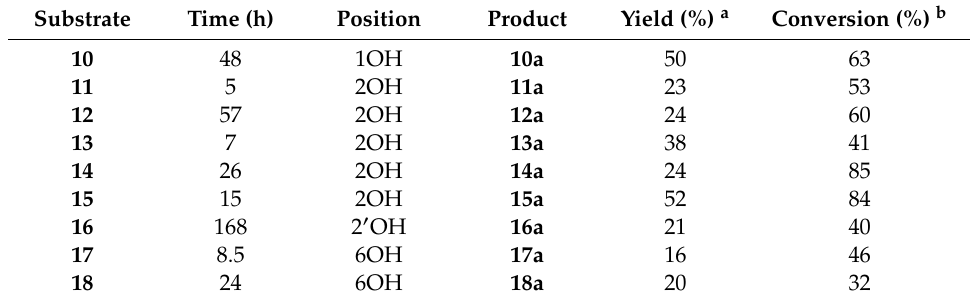
Table 4. Regioselectiveenzymaticdeprotectionofmannose-baseddisaccharides( 10 – 18 )usingAXE-GLX-AG.